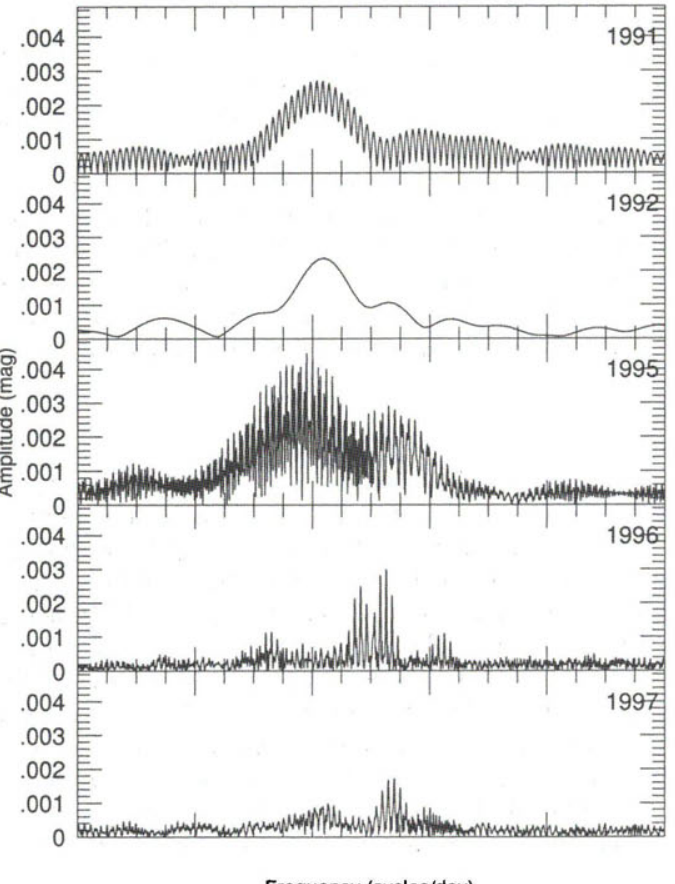
Fig. 2. The Fourier transforms of our data for each